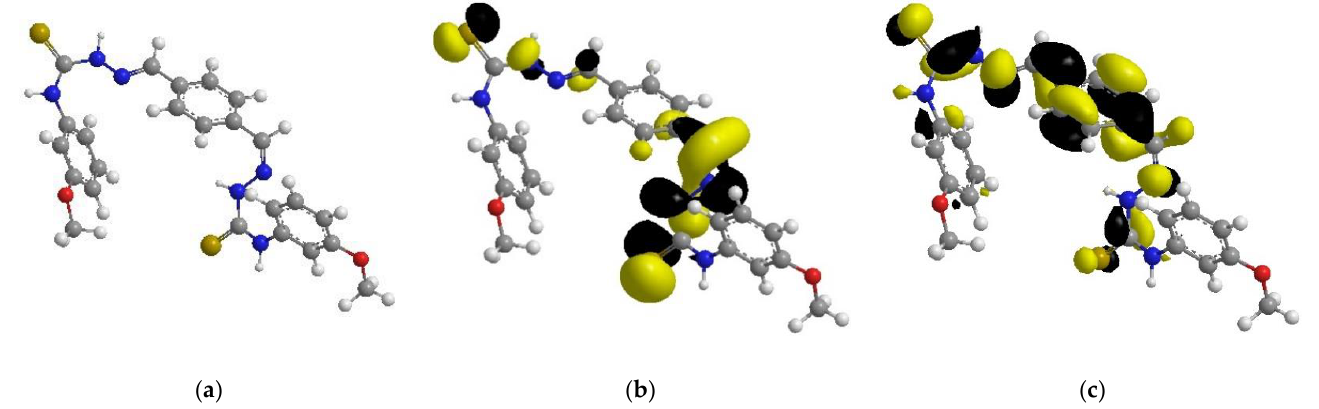
Figure 11. The optimized chemical structure ( a ), highest occupied molecular orbital ( b ), and lowest unoccupied molecular orbital ( c ) of the tested